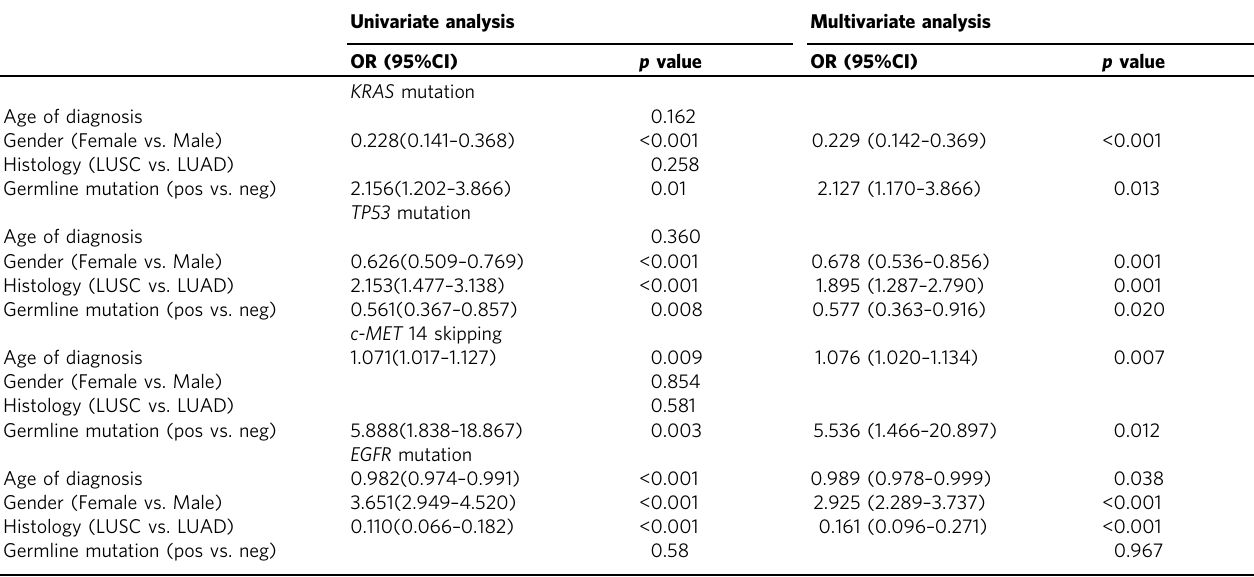
Table 3 Correlation between germline mutation status and somatic